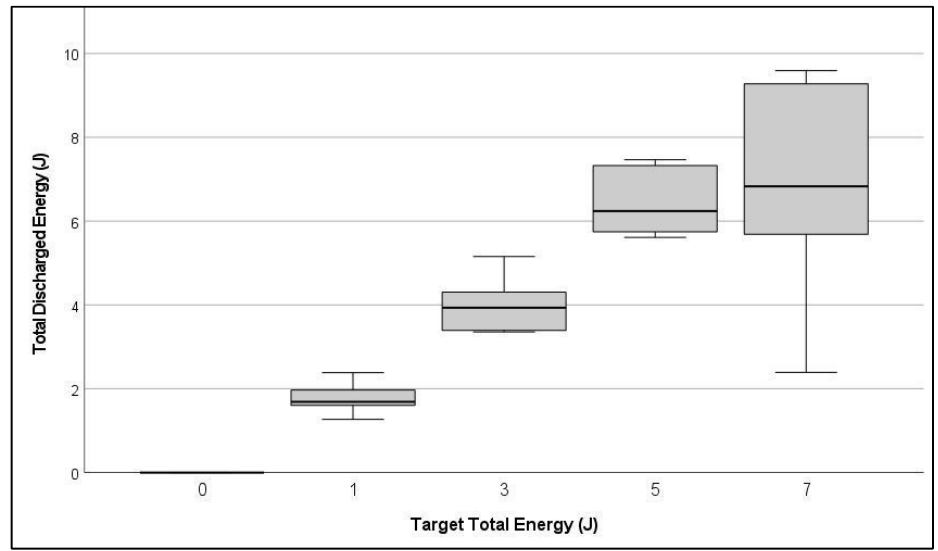
Figure 7. Box plot of total discharged energy by target discharged energy show higher variance among the 7 J treated Amaranthus powellii plants.